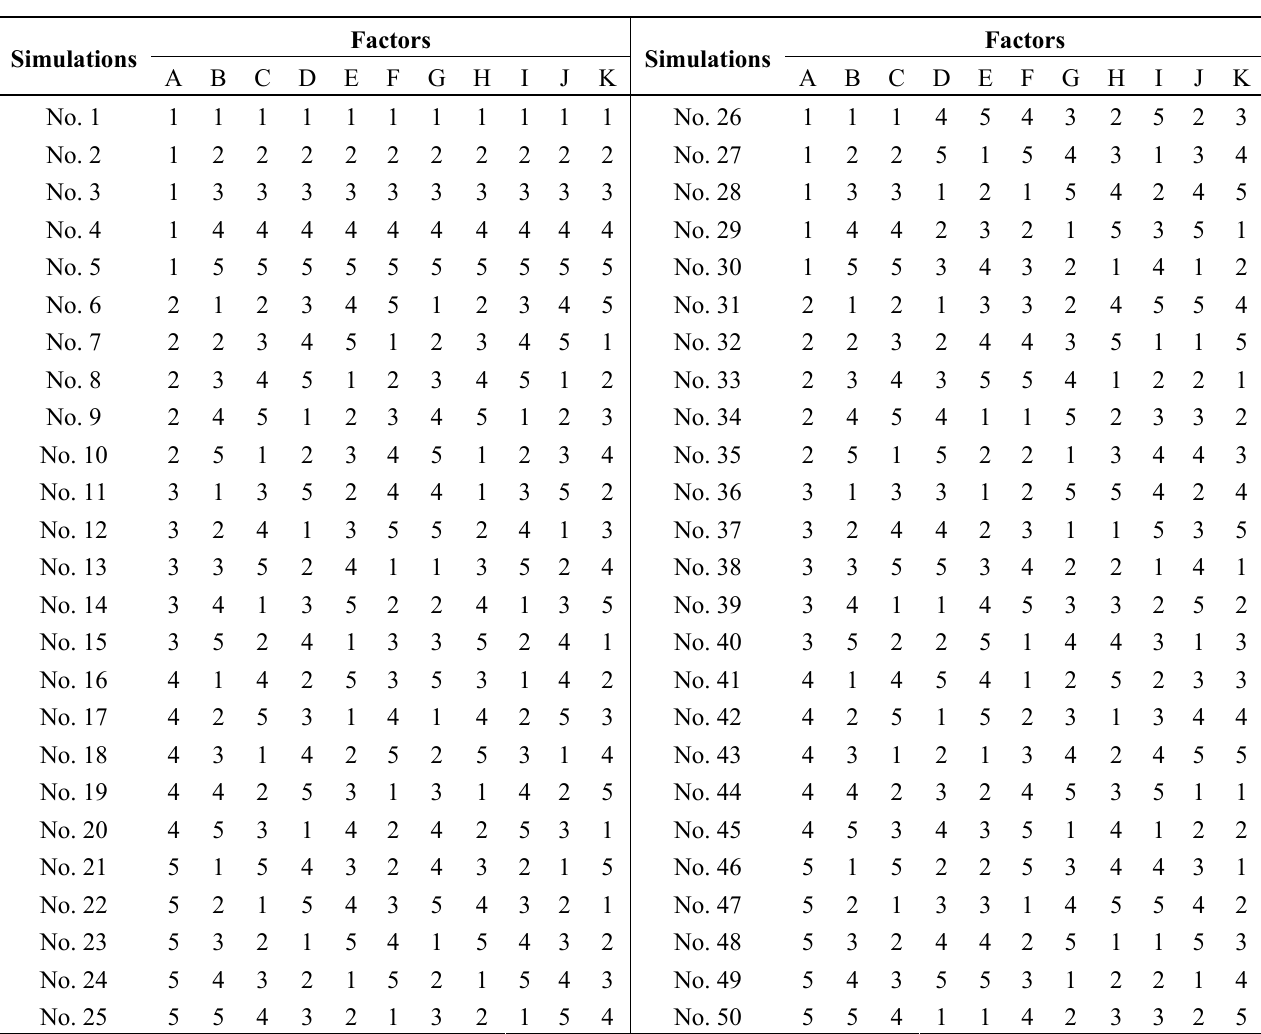
Table 1. Orthogonal Array L 50 (design